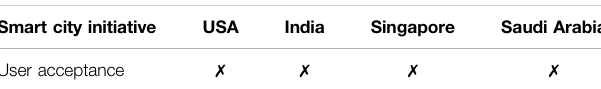
TABLE 2 | User acceptance in different smart cities ’